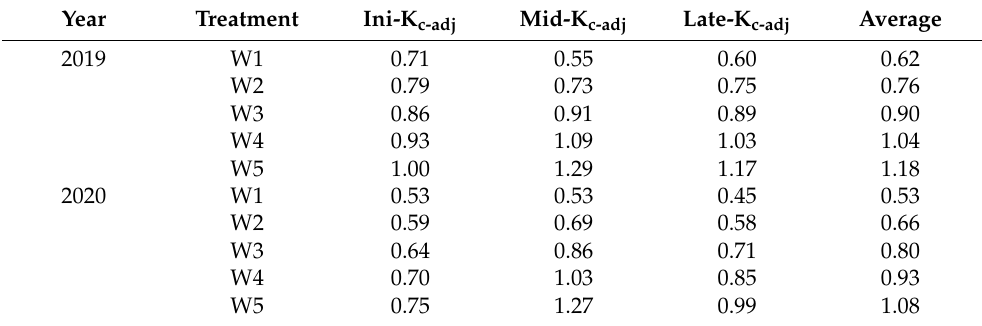
Table 5. K c-adj at different growing stages of apple orchard in different treatments in 2019 and 2020.